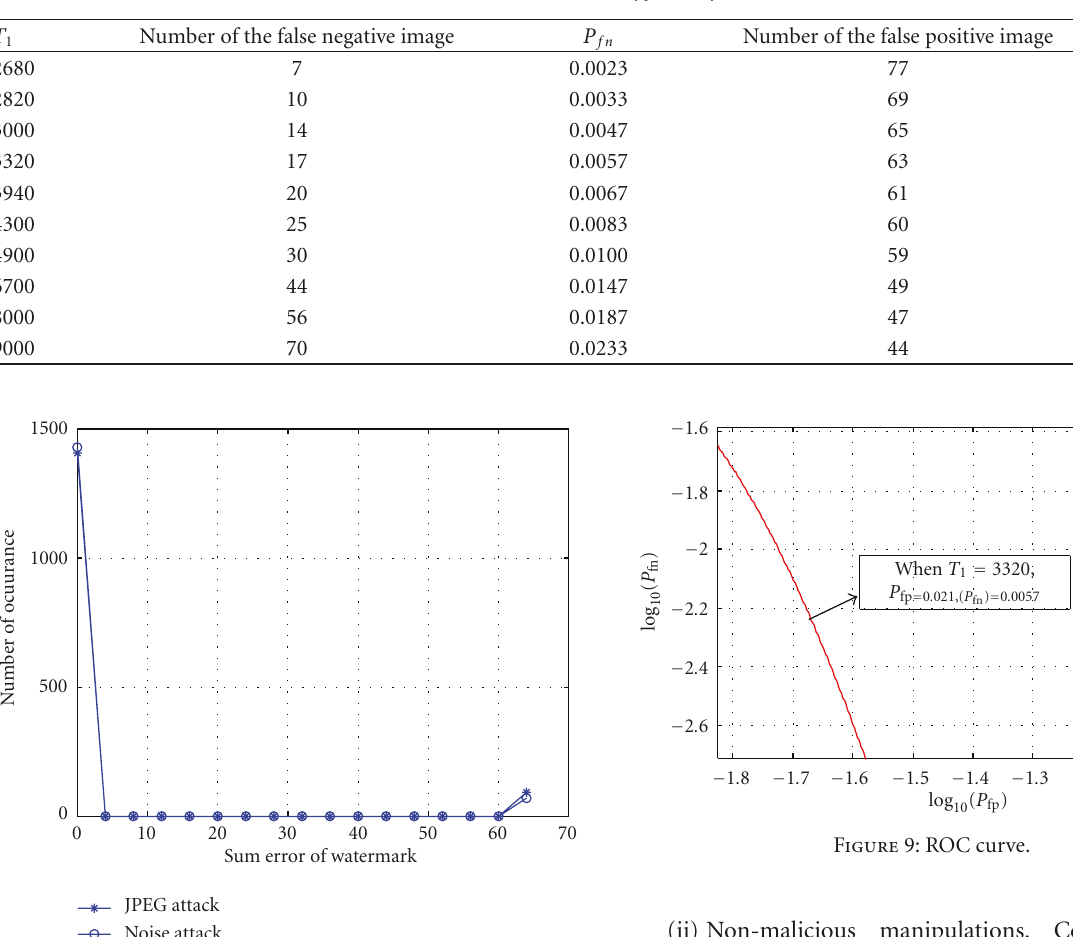
Table 2: Some P f p and P fn .